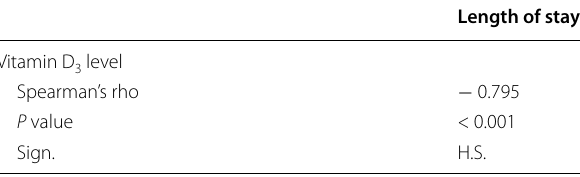
level and length of 3